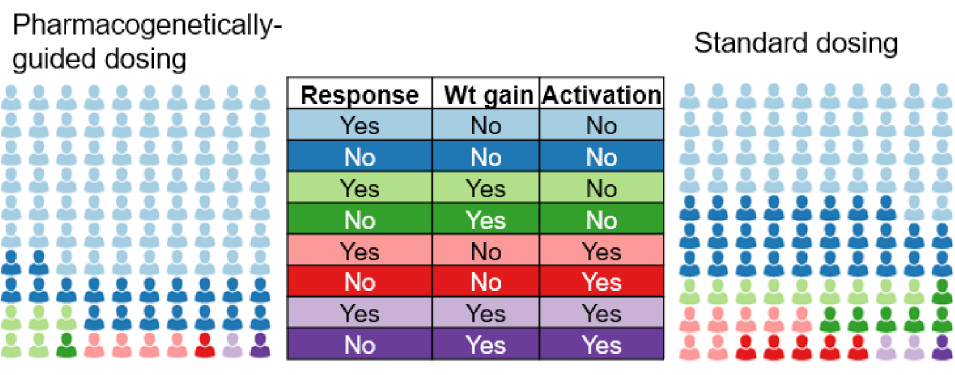
Figure 3. Expected response rates and rates of specific adverse events (weight gain and activation) in patients receiving pharmacogenetically-guided and standard escitalopram